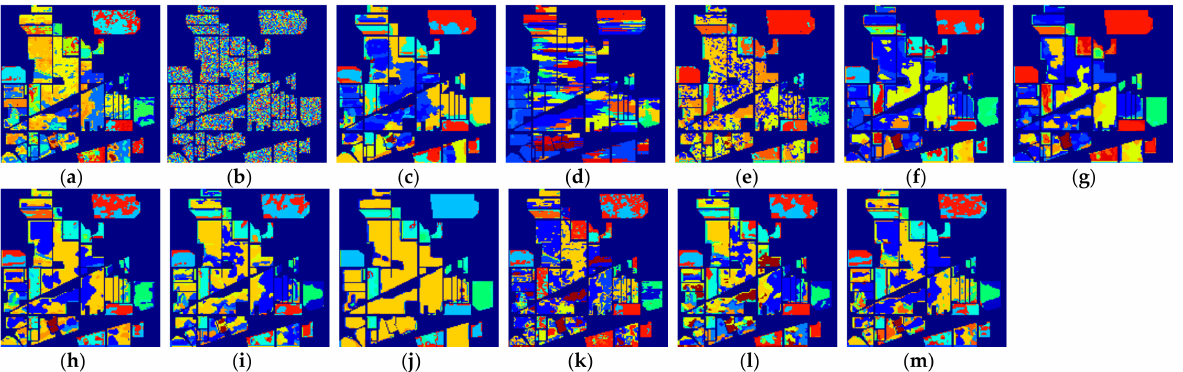
Figure 15. The classification maps of all methods with one sample on Indian Pines dataset. ( a ) SVM; ( b ) SS-LapSVM; ( c ) 3D-DENSEnet; ( d ) 3D-Gan; ( e ) SS-CNN; ( f ) 3D-CNN; ( g ) 3D-CNN k - means ( h ) 3D-CNN ours ; ( i ) 3D-CNN hardlabel ; ( j ) SSRN; ( k ) SSRN k - means ; ( l ) SSRN ours ; ( m ) SSRN hardlabel